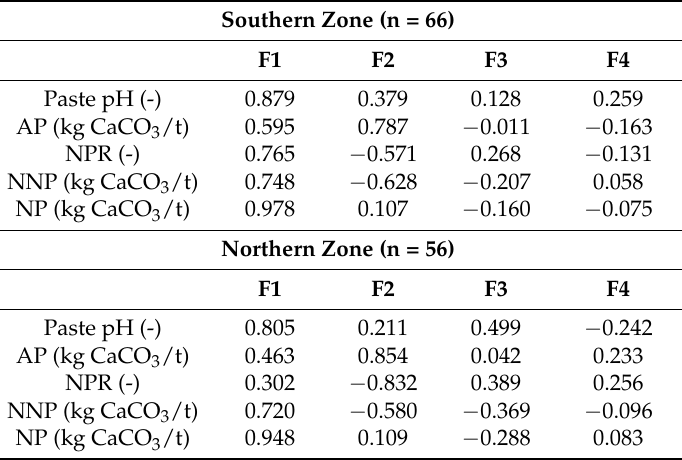
Table 4. Correlations between variables and factors for the southern and northern zones ( p <